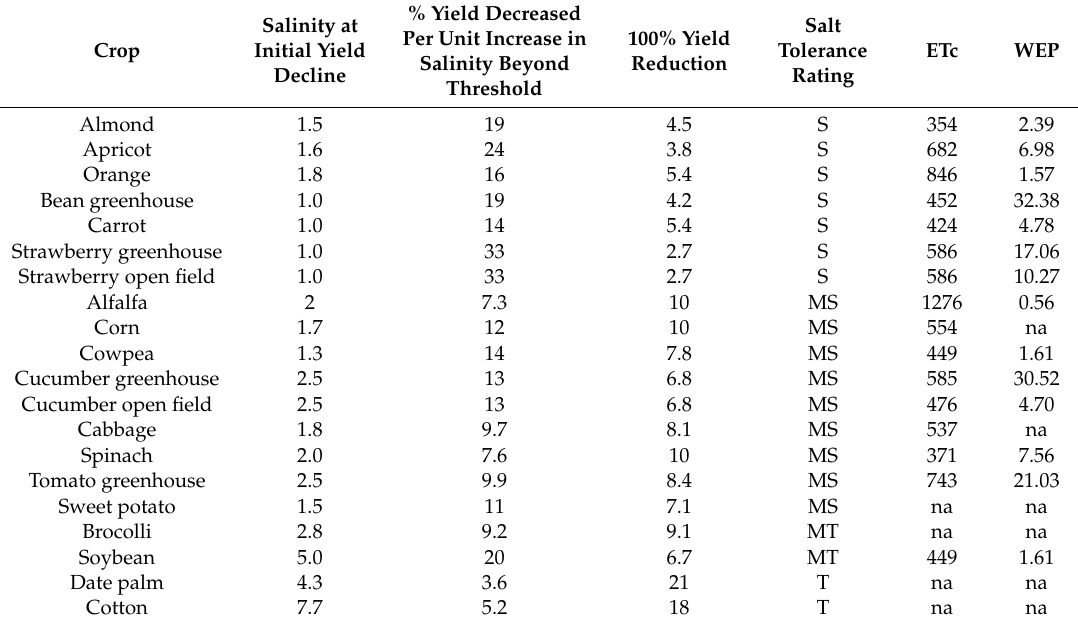
Table 2. Crop salt tolerance and yield potential as a ff ected by irrigation water salinity (dS m − 1 ), adapted from [23]. Crop evapotranspiration (Etc; mm) and water economical productivity (WEP; € m − 3 ) of the main cultivated crops in Cyprus [43].